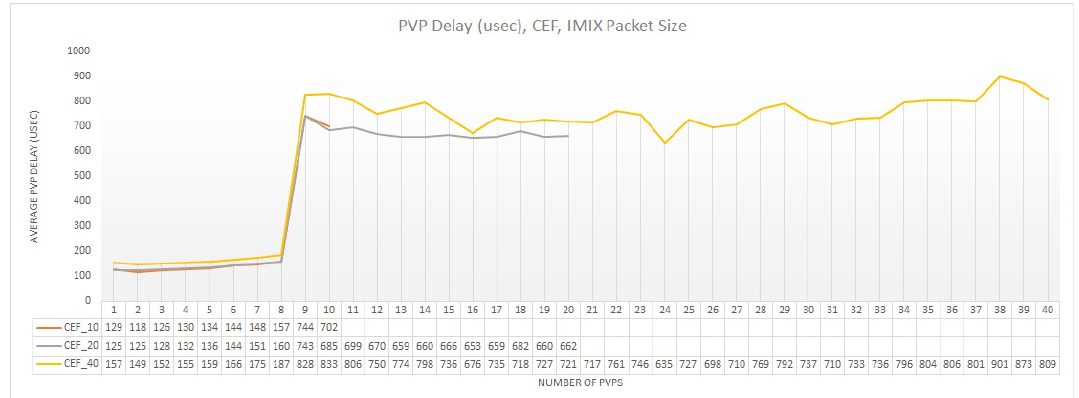
Figure 11. Single-Feature multi-PVP average delay with